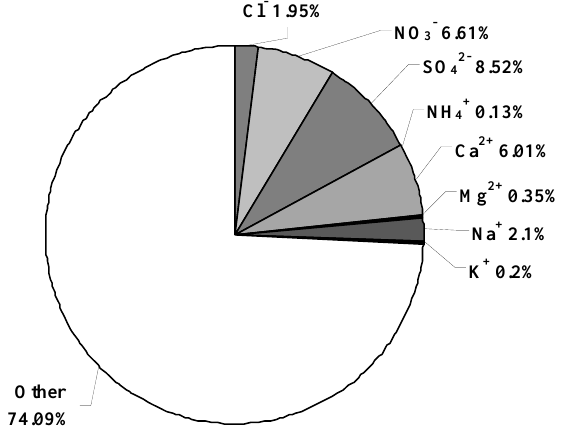
Fig. 14. Average chemical composition (mass percentage) of the deposited particles on passive particle collectors.